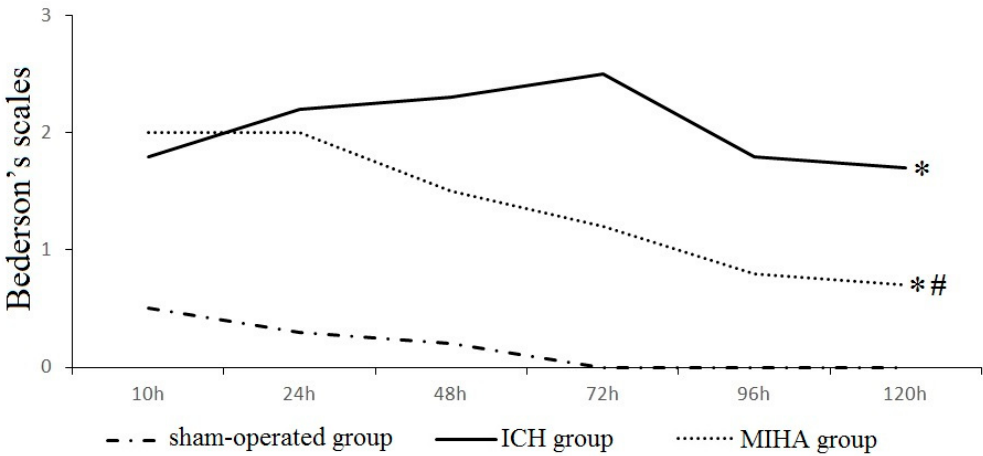
Figure 1. The Bederson’s scales of different groups at each time point. * p < 0.05 vs. the sham-operated group, # p < 0.05 vs. the intracereral hemorrhage (ICH) group.